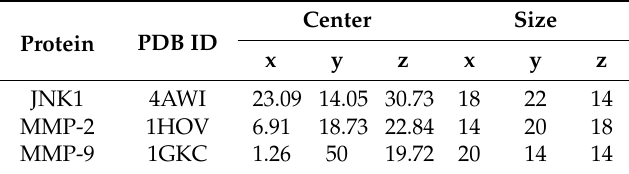
Table 1. The parameters of molecular docking